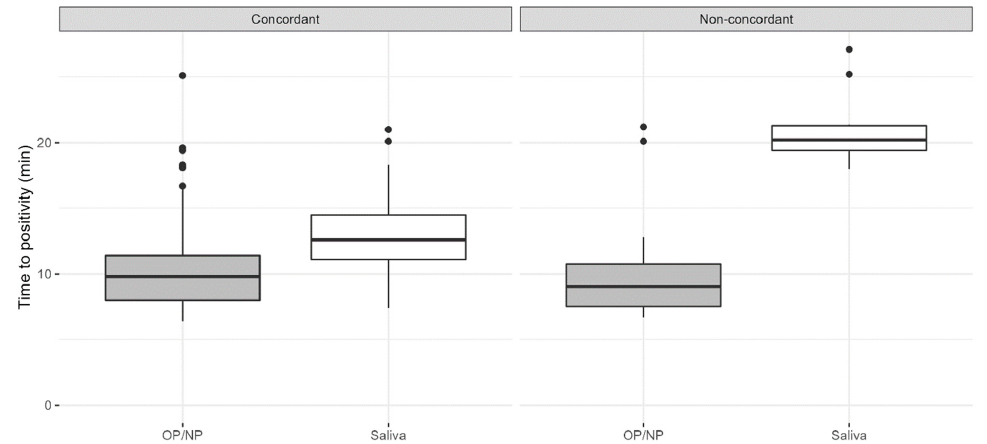
Figure 3. Time to positivity (TTP) of the RT-TMA compared between OP/NP swabs and saliva samples for concordant (both positive) samples (left panel), OP/NP positive and saliva negative samples and OP/NP negative and saliva positive samples (right panel). These box-whisker-plots present the median (IQR) time to positivity for the positive samples (OP/NP and/or saliva) from participants with concordant RT-TMA results (both OP/NP swab and saliva sample positive) and non-concordant RT-TMA results (either OP/NP swab or saliva samples negative).